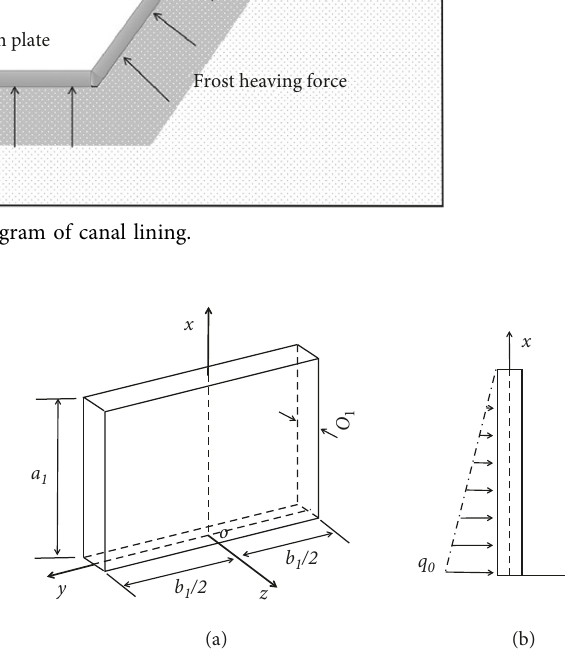
Figure 2: Diagram of force acting on the rectangular slope under frost heaving